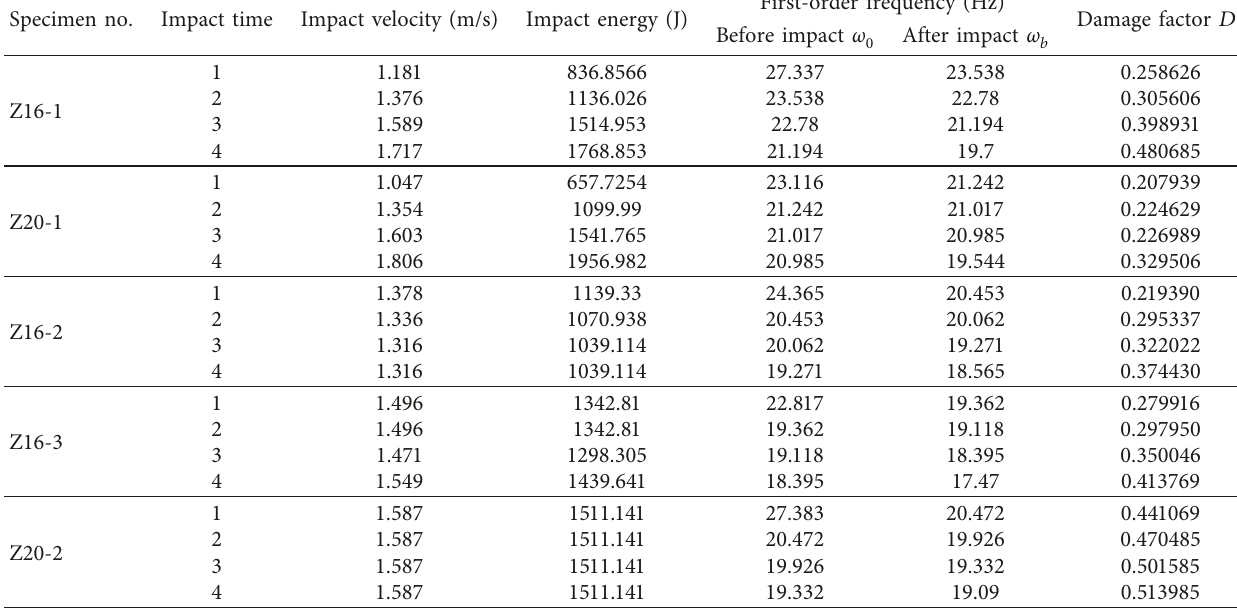
Table 6: Identification of the pier damages using the modal frequencies of the test columns. Specimen